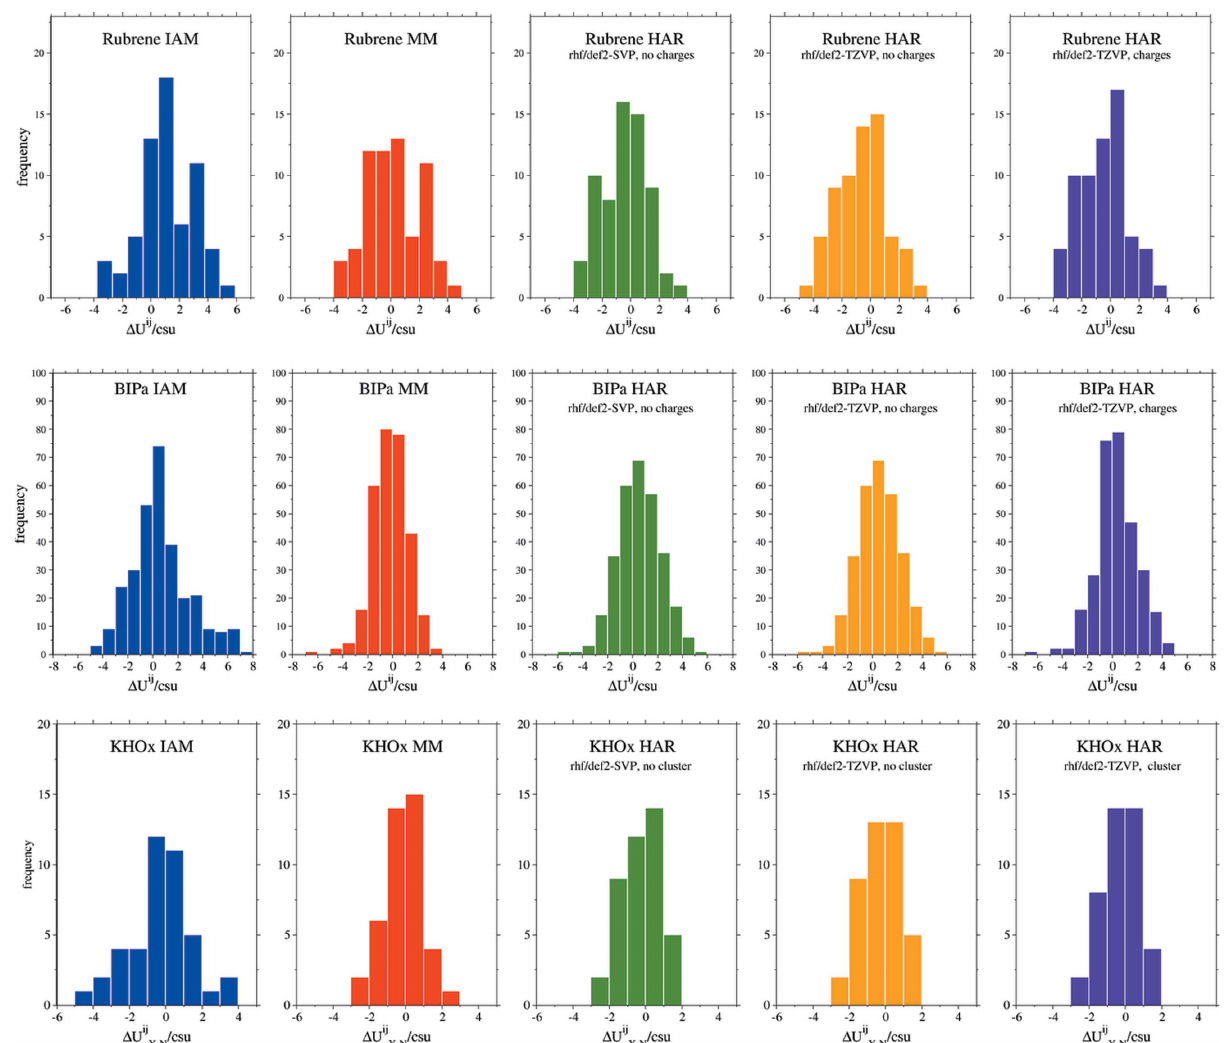
Figure 4 Histograms showing binned ratios (cid:2) U ij